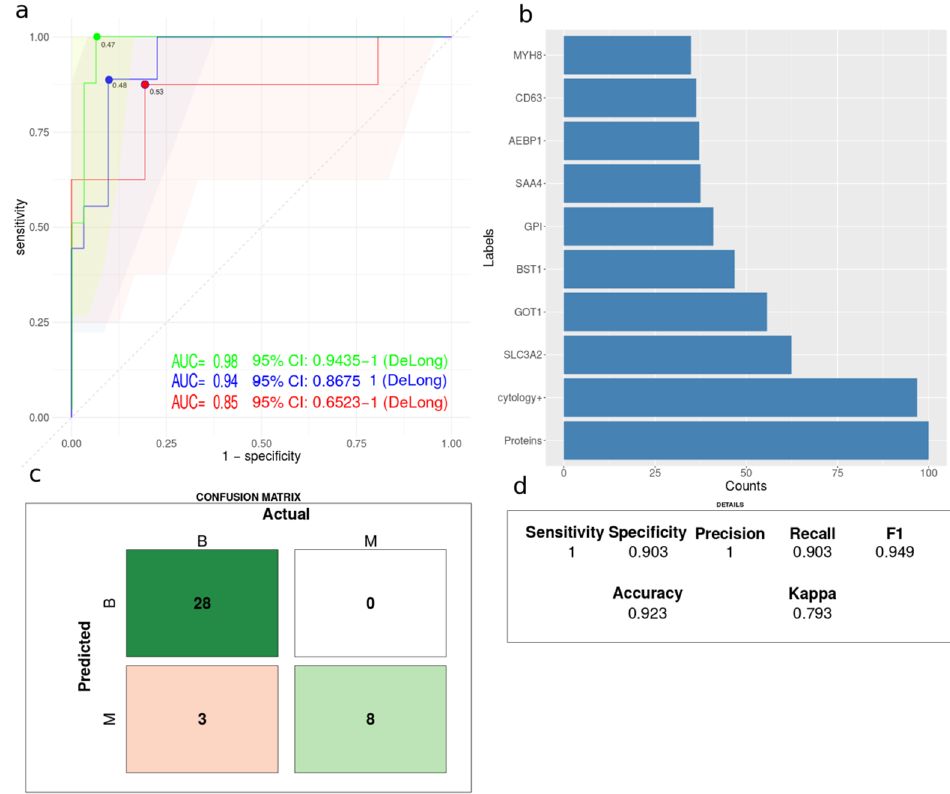
Figure 5. Performance of partial least squares regression analysis. ( a ) Receiver operating characteristics for three PLS regression models based on clinical data (red), label free quantitative proteomics data (blue) and clinical and label free quantitative proteomics data (green). The dot indicates the optimal cut of threshold based on Youden’s J statistic. ( b ) Histogram of the importance of the top 10 variables of PLS regression model trained on clinical and PE proteome data. The term “proteins” indicates total protein concentration. ( c ) Confusion matrix and ( d ) performance measures evaluated using the PLS regression model trained on clinical and PE proteome data and test data as input.